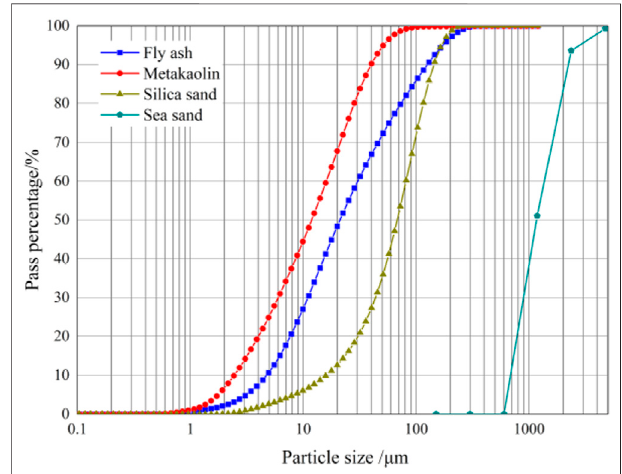
FIGURE 1 | Particle size distribution of fl y ash, metakaolin, silica sand, and sea